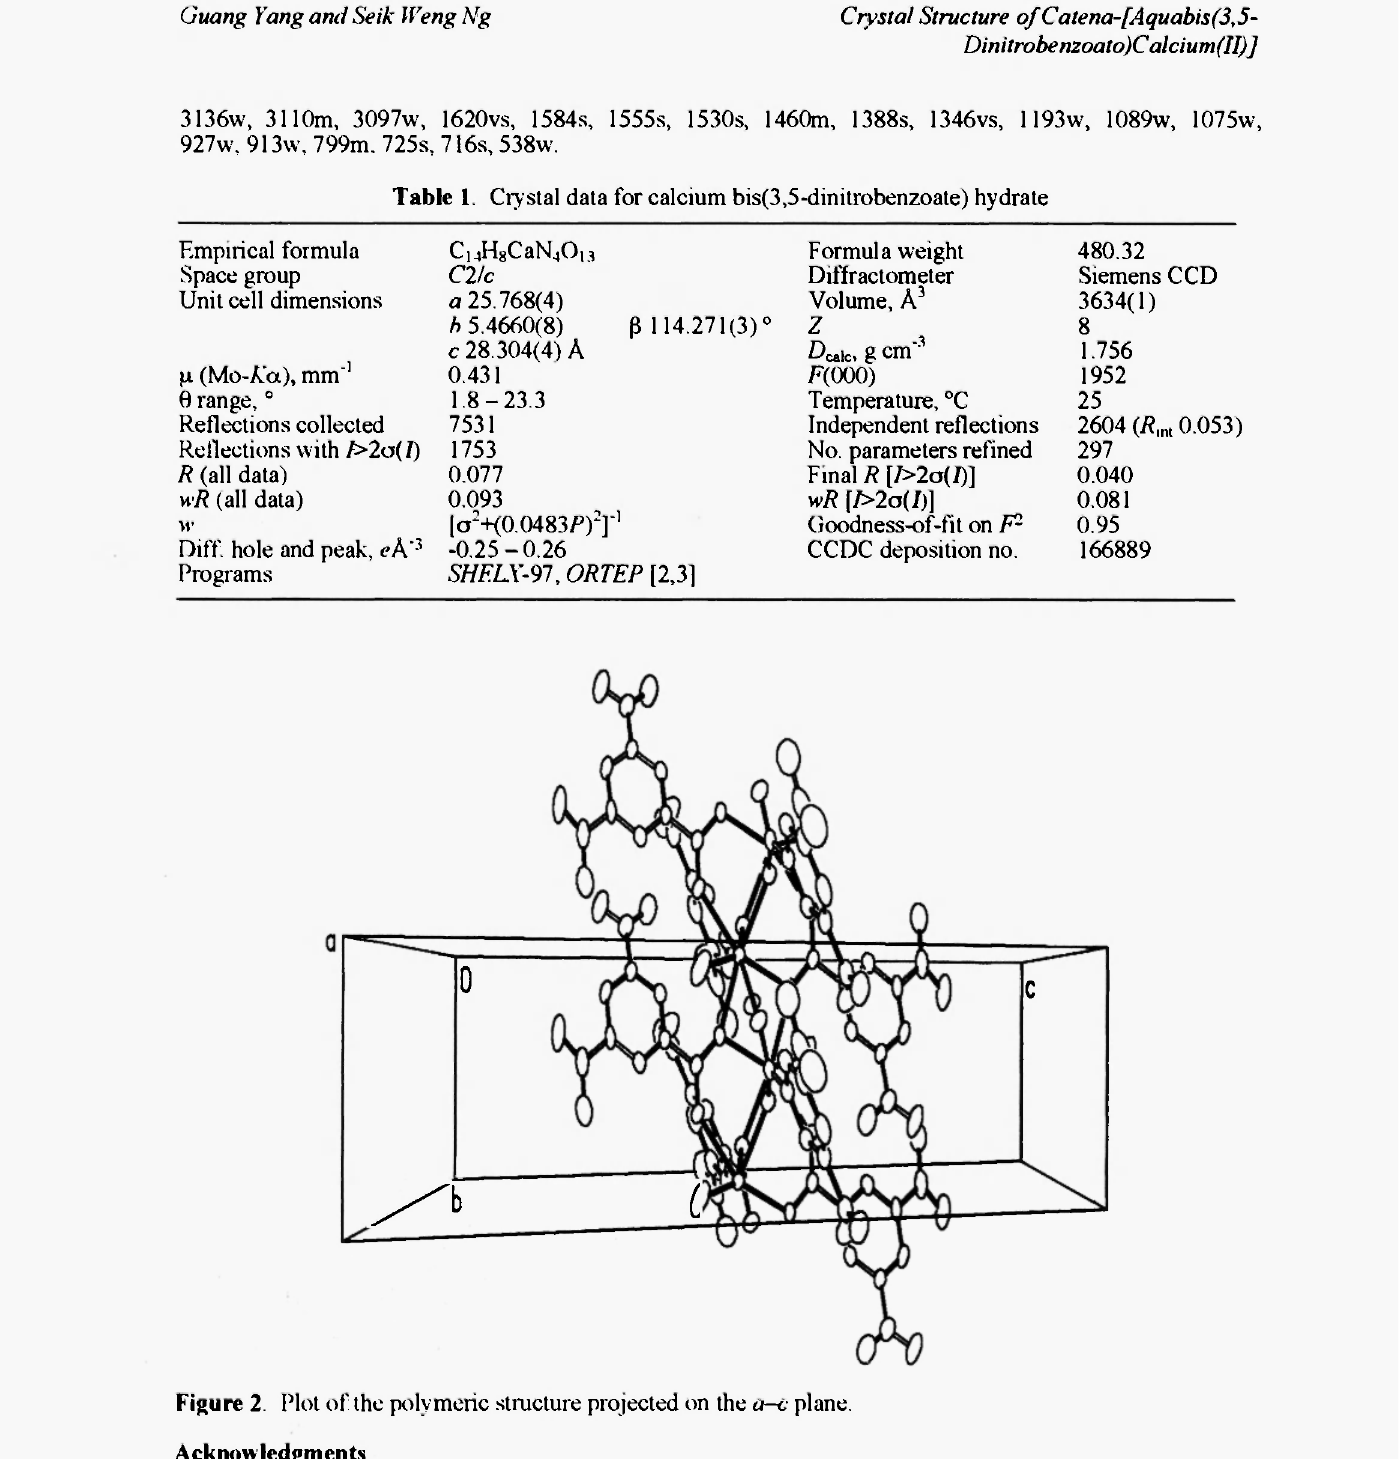
Figure 2 Plot of the polymeric structure projected on the a-c